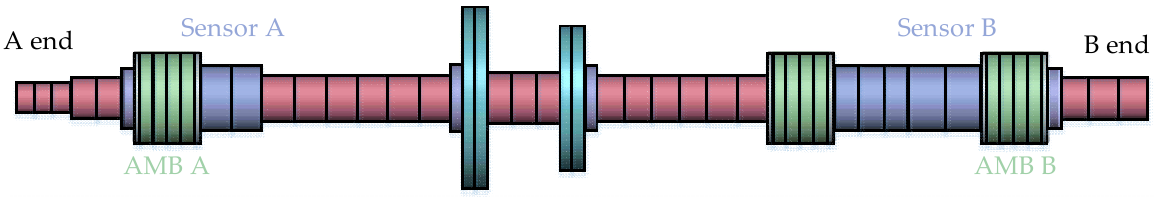
Figure 4. Finite element model of the flexible rotor.